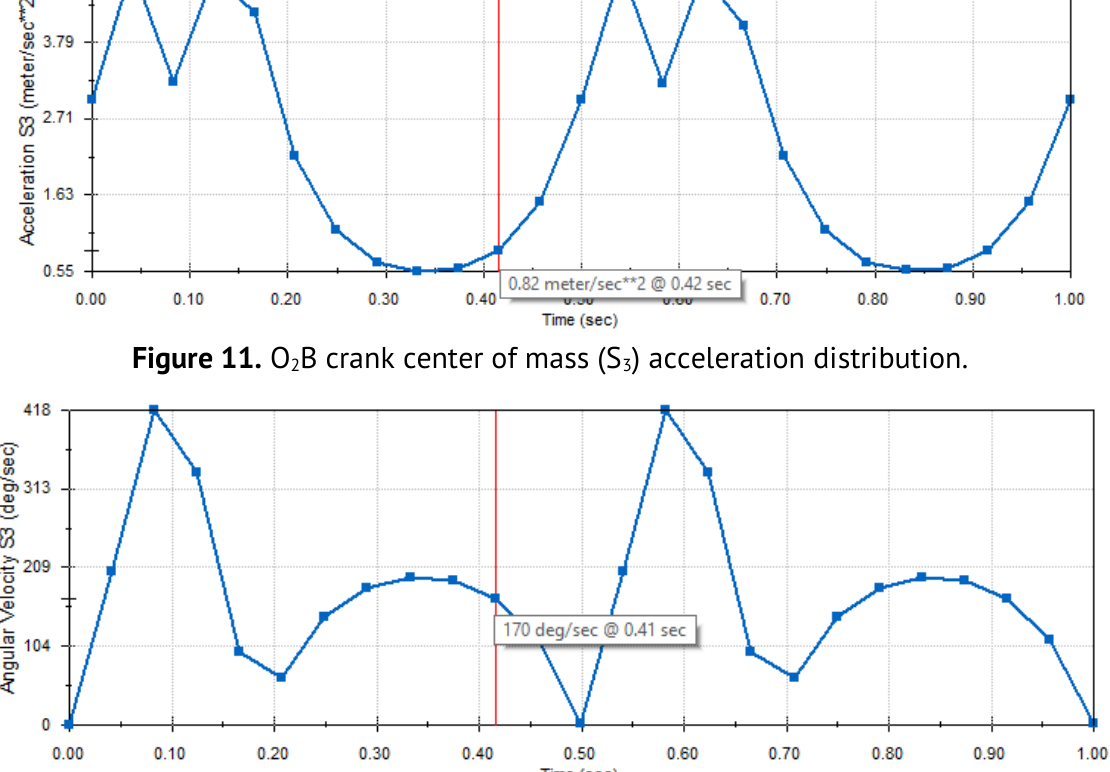
) angular velocity 3